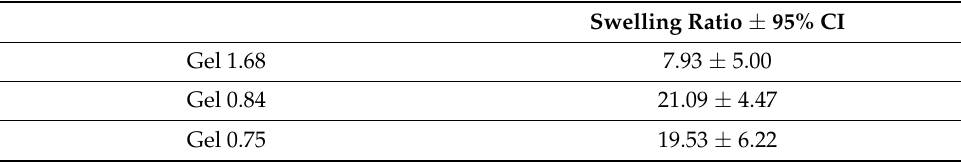
Table 2. Swelling ratio of hydrogels ( n = 5) were evaluated by measuring their wet and their respective lyophilized dry weights.